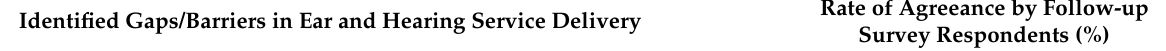
Table 2. Gaps and barriers to current ear and hearing service delivery identified by forum stakeholders, and the rate of agreeance by follow-up survey respondents ( n =